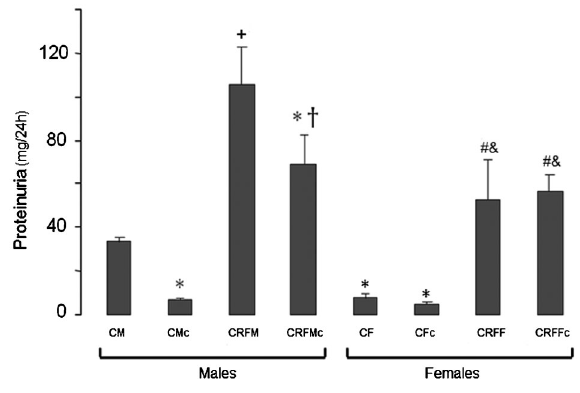
Figure 2. Proteinuria (mg/24 h) after 30 days. C: control; c: castration; CRF: chronic renal failure; F: female rat; M: male rat. P , 0.05: + vs all; * vs CM; { vs CMc; # vs CF; & vs CFc.